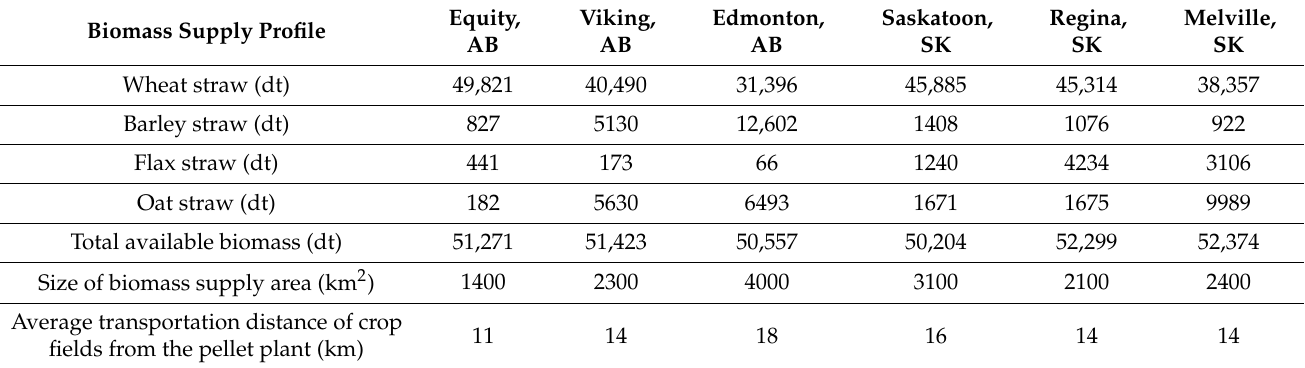
Table 1. Biomass supply profile of the six selected locations as the potential sites for the production of ag-pellets. Biomass Supply Profile